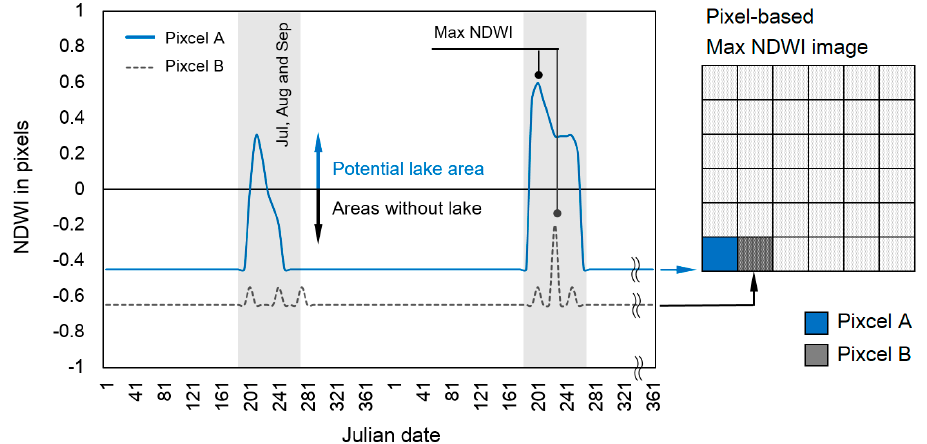
Figure 3. The pattern diagram of potential lake areas without lakes based on pixel-based maximum Normalized Difference Water Index (NDWI) images. In the schematic diagram of NDWI shown in Figure 2, pixel A is extracted as a potential lake area, and pixel B is extracted as an area without a lake from September 2000 through July 2014.